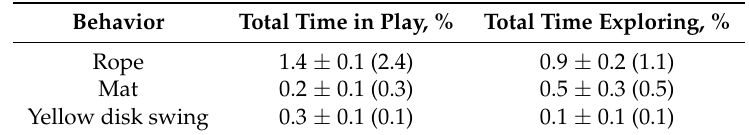
Table 3. The SQRT transformed proportion of use, for each material provided (rope, mat and yellow disk swing) and the amount of play and exploration calculated per sow * ,1 .